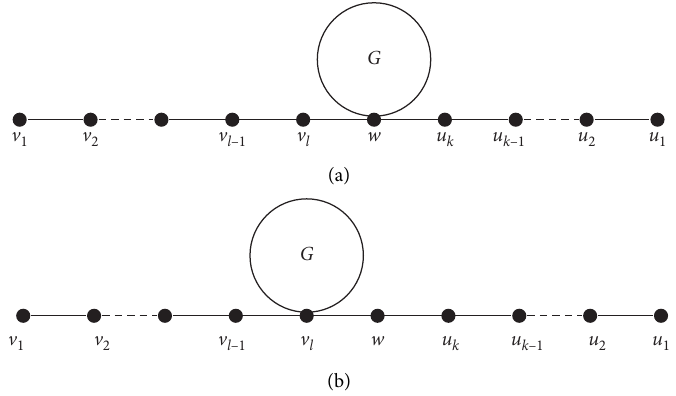
Figure 5: The graphs P , Q , G , G